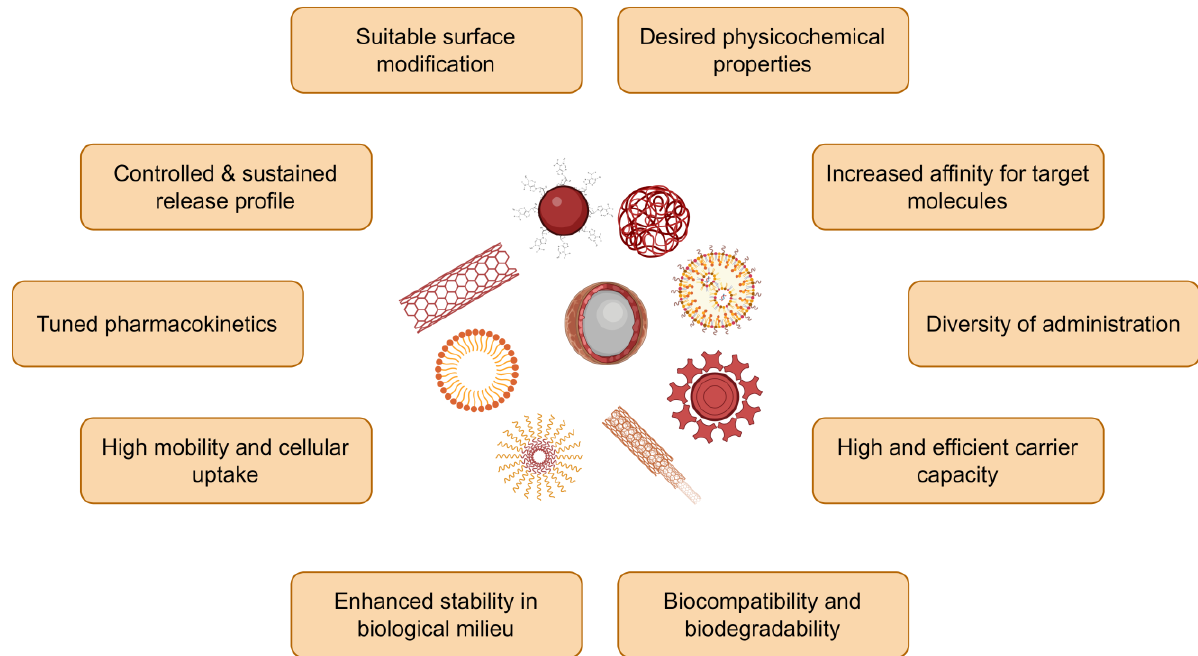
Figure 1. Main advantages of nanoparticles in biomedicine. Explored nanoplatforms in the biomedical field might be organic, inorganic, or hybrid. Inorganic NPs might be of different compositions, such as core-shell quantum dots and passivated inorganic NPs by an organic/polymeric layer, and of various shapes, such as spheres and nanotubes. Liposomes, polymeric NPs, and biopolymer-based NPs are some examples of organic NPs.